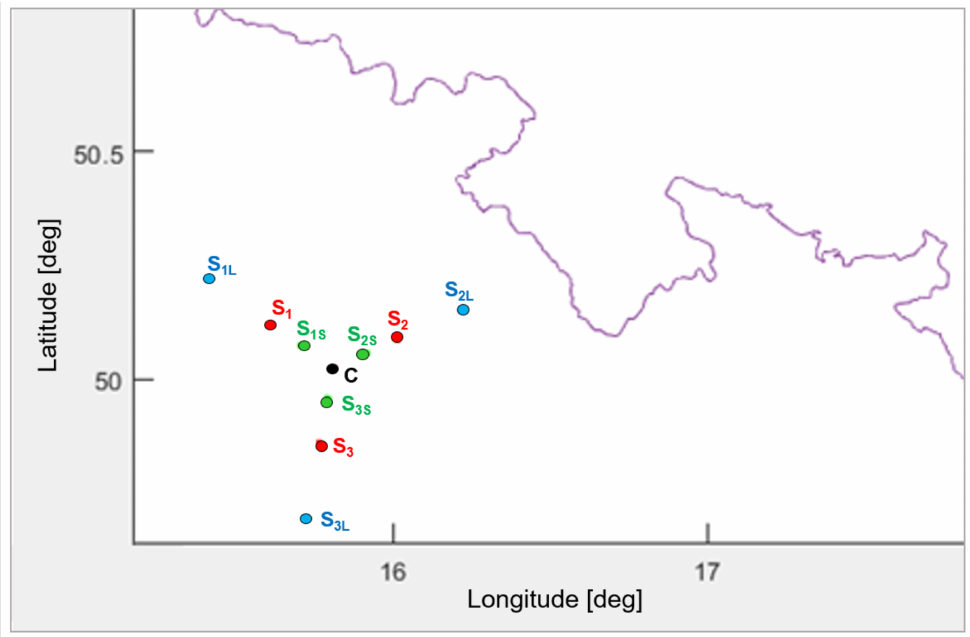
Figure 9. MLAT deployment— standard , short , and long configurations.